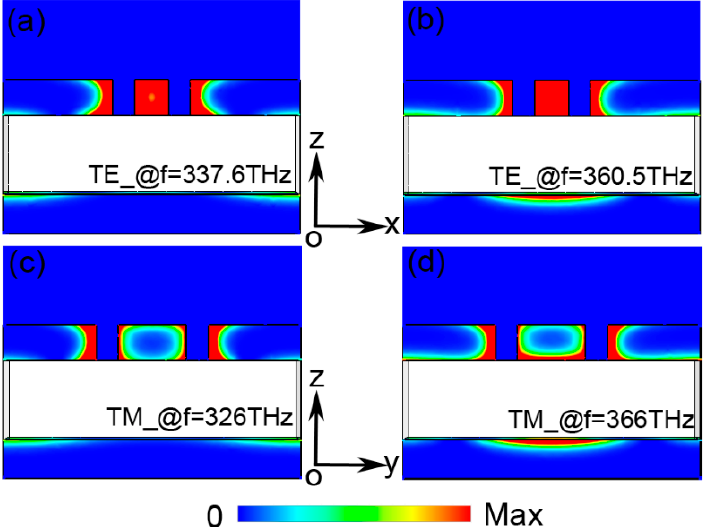
Figure 4. Power loss density at resonant frequencies ( a ) f = 337.6 THz and ( b ) f = 360.5 THz in the xoz plane for TE-polarized wave. Power loss density at resonant frequencies ( c ) f = 326 THz and ( d ) f = 366 THz in yoz plane for TM-polarized wave.